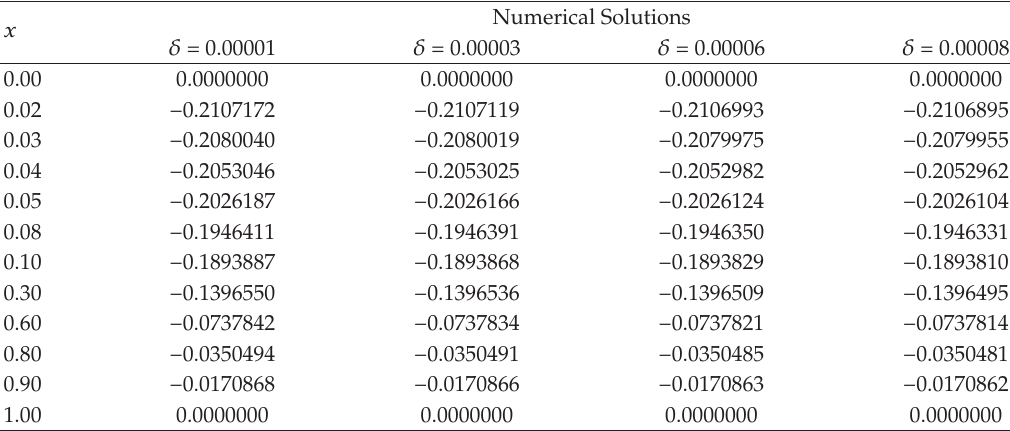
Table 10: Numerical results of Example 4.4 for ε (cid:8) 0 . 0001, N (cid:8) 100, and di ff erent values of δ